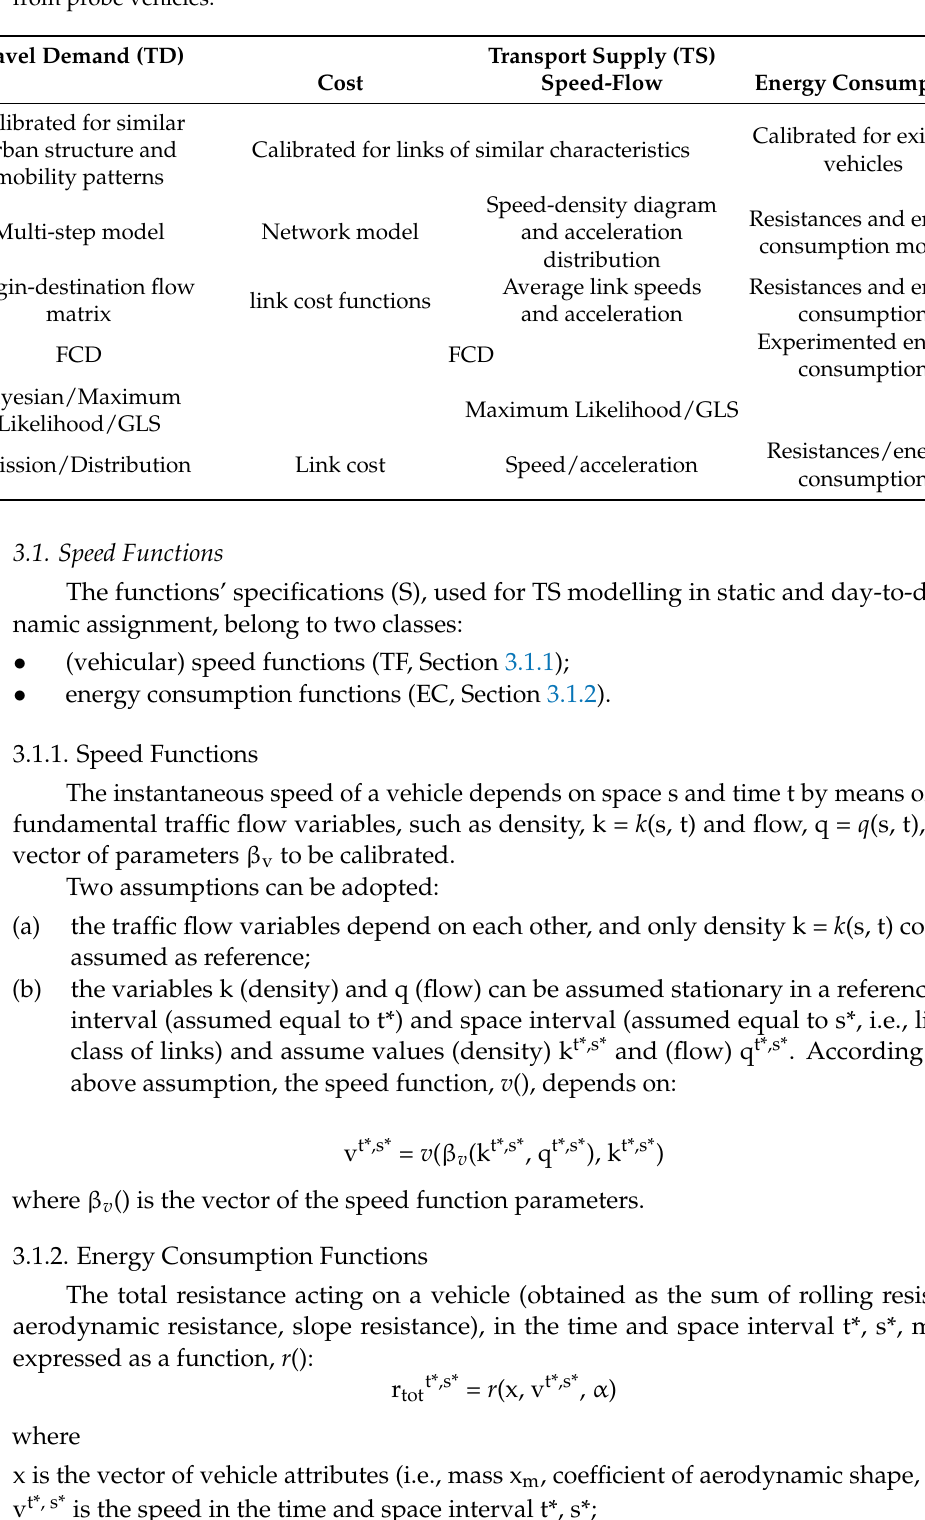
Table 1. Areas of application of the proposed framework and parameters calibration from FCD and from probe